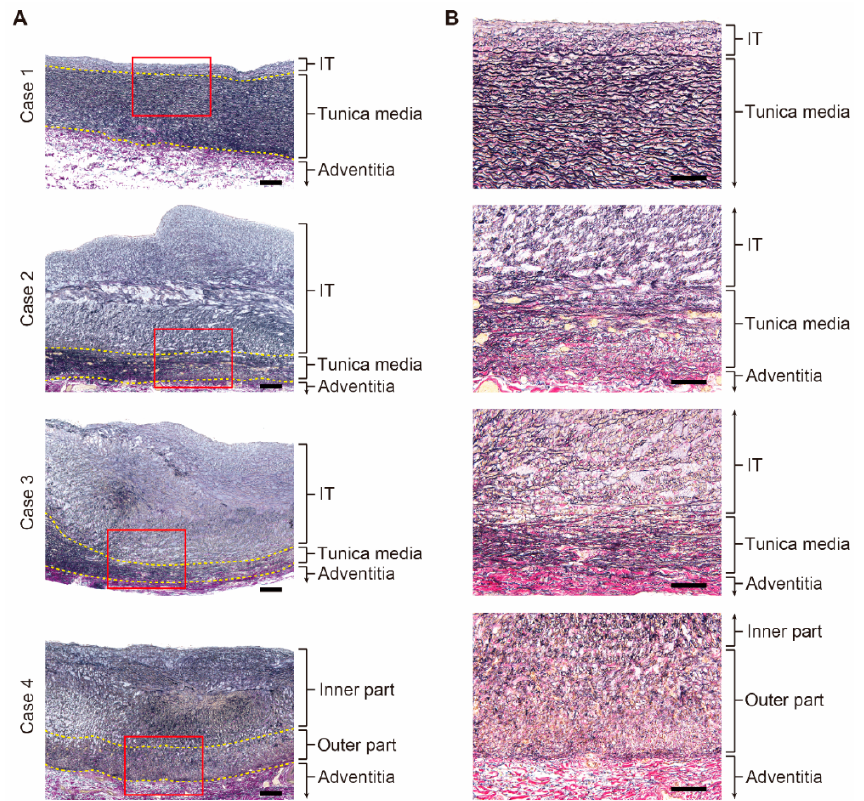
Figure 1. Histological analysis of the human ductus arteriosus (DA) tissues. ( A ) Lower magnification images of the Elastica van Gieson stain of the human DA tissues. The yellow dotted lines indicate the border between the intimal thickening (IT) and the tunica media and the border between the tunica media and the adventitia. Scale bars: 200 µm. ( B ) Magnified images of red boxes in ( A ). Scale bars: 100 µm.